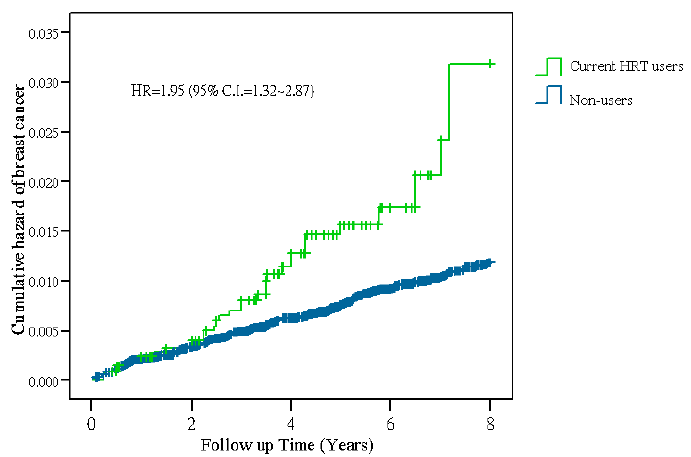
Figure 1. Kaplan-Meier estimates of cumulative breast cancer hazards of the middle-aged cohort, stratified by HRT use. Table 1. The breast cancer incidence of current hormone replacement therapy (HRT) users and non-users from 1997 to